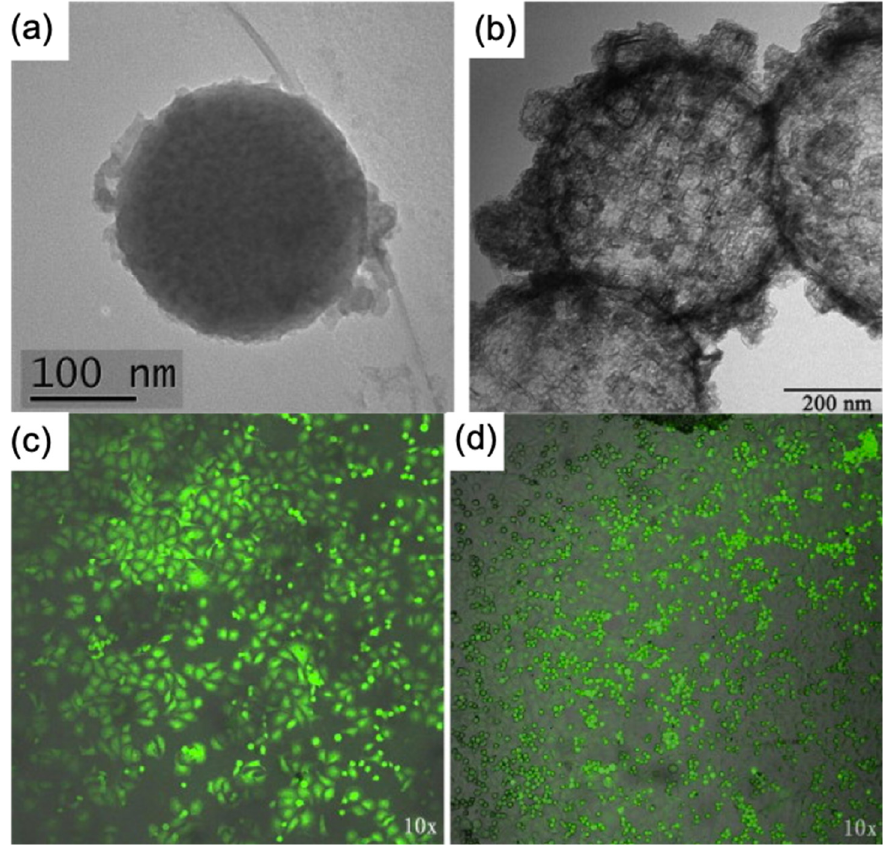
Figure 20. TEM images of ( a ) Fe 3 O 4 @SiO 2 NPs and ( b ) FGQCs. Laser scanning confocal microscopy in vitro bioimaging of ( c ) FGQC NPs and ( d ) 5-FU-FGQCs in the hepatoma cell line SMMC-7721. Adapted with permission from reference [61]. Copyright 2014 Elsevier.